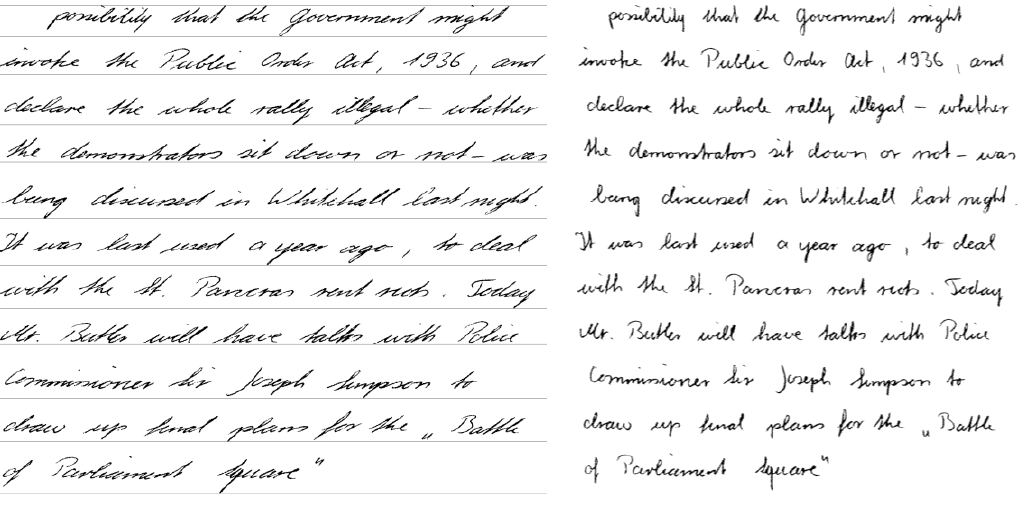
Figure 1. An example of a slant removal application resulting from the detection algorithm described in [9]. Text-line segmentation is required prior to slant estimation.